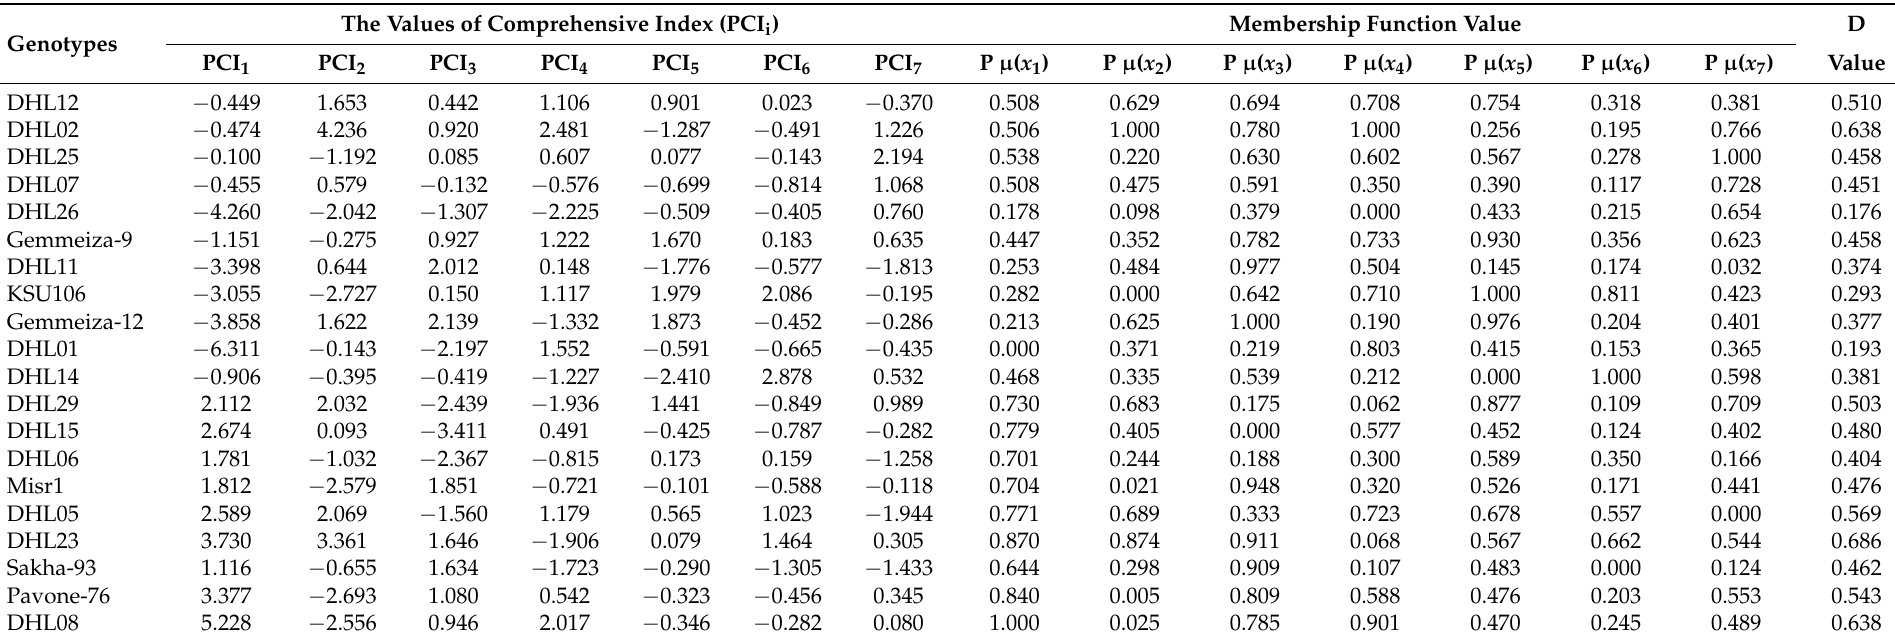
Table 4. The values of comprehensive index (PCIi), index weight, P µ ( x i ), D and regression D (cid:48) for each wheat